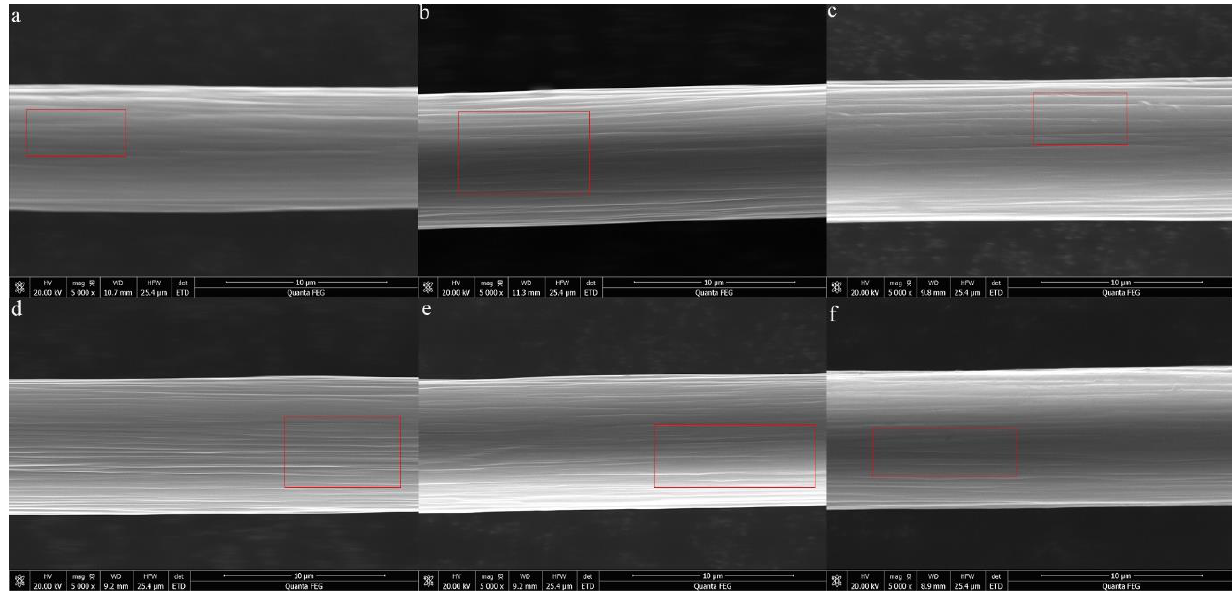
Figure 6. SEM images of the samples: ( a ) 700-3; ( b ) 700-9; ( c ) 750-3; ( d ) 750-9; ( e ) 800-3; ( f ) 800-9.